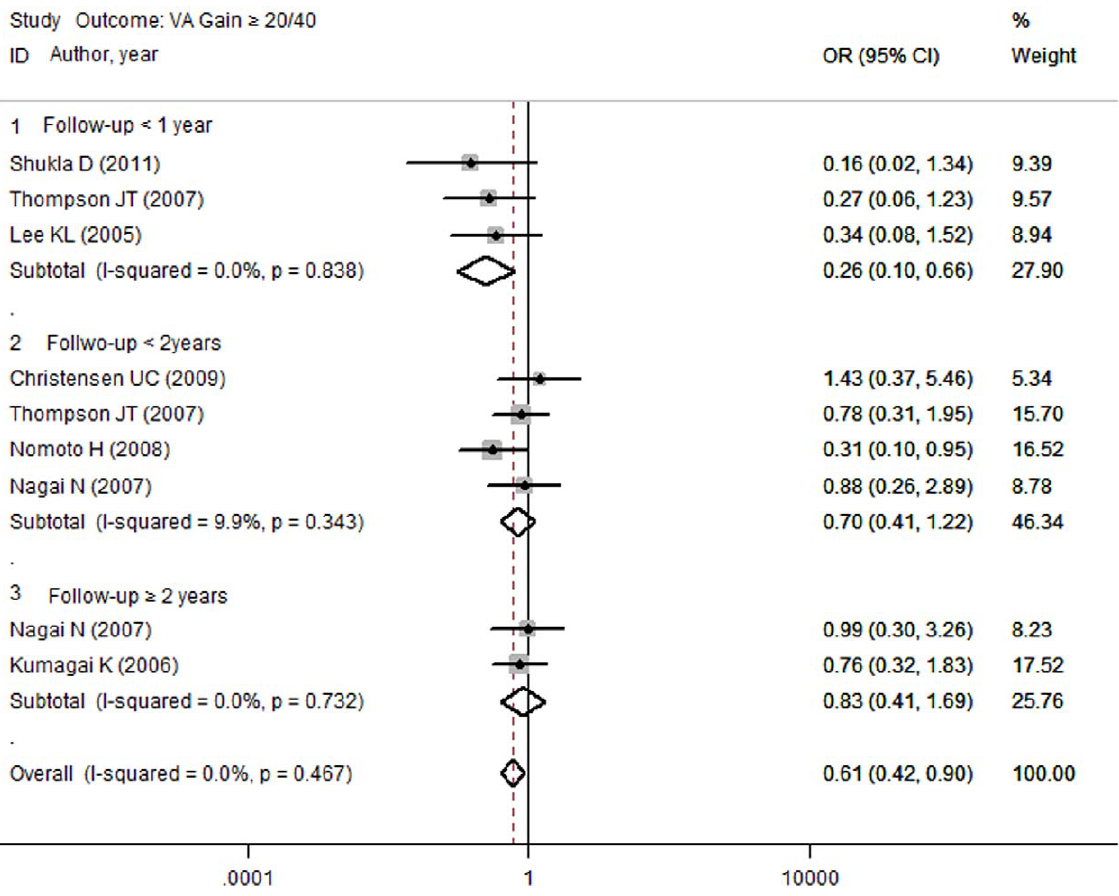
Figure 2. Forest plot for VA gain $ 20/40 in different follow up duration. The rate of VA gain $ 20/40 was lower in ICG group compared with the non-ICG group, while no difference was observed in longer follow-up duration.